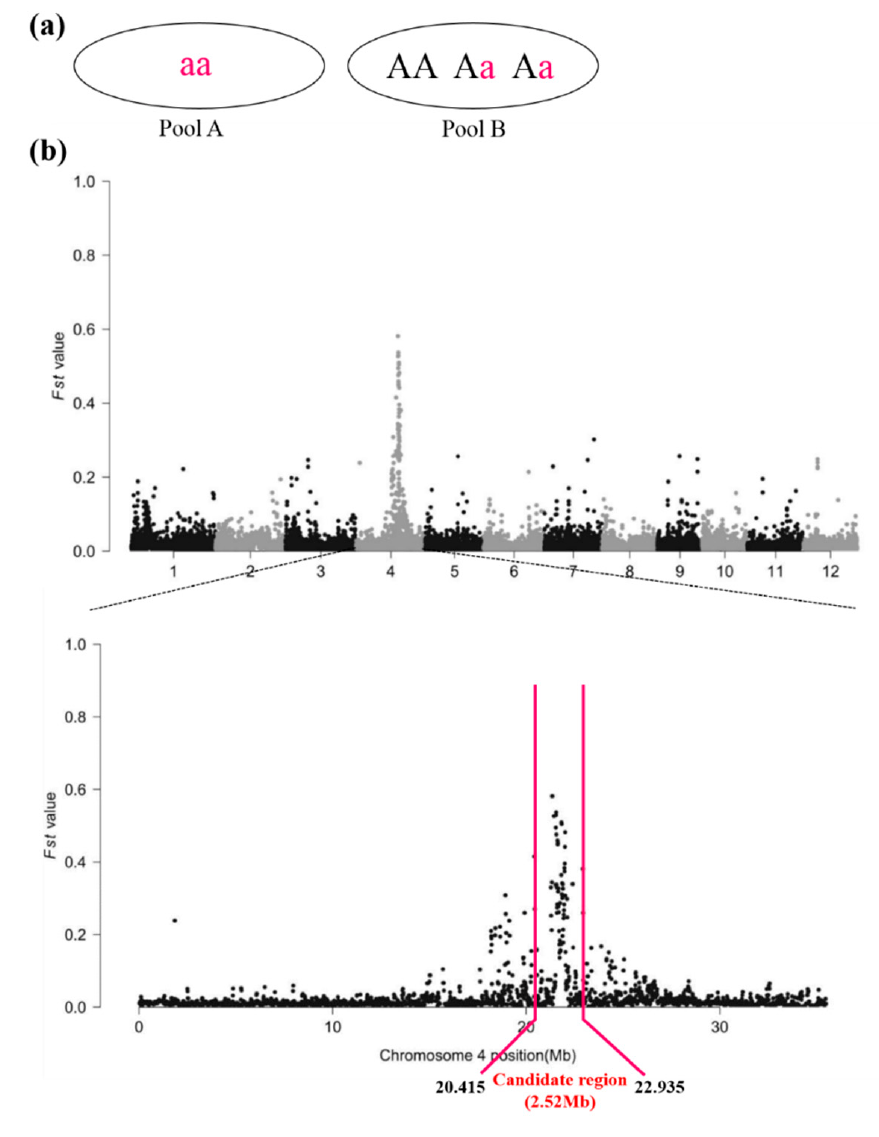
Figure 3. Candidate region of wb1 obtained by the modified MutMap method. ( a ) An example for explanation of ∆ (SNP index) for the casual SNP. Theoretically, SNP index (A) would be 1, SNP index (B) 0.333 (1/3), and thus ∆ (SNP index) would be 0.667 (1 minus 1/3); ( b ) ∆ (SNP indices) Manhattan plot. Fst value, defined as the proportion of genetic diversity due to allele frequency differences among populations described by the previous report [38]. ∆ (SNP indices) and Fst values have the same meaning in this study.